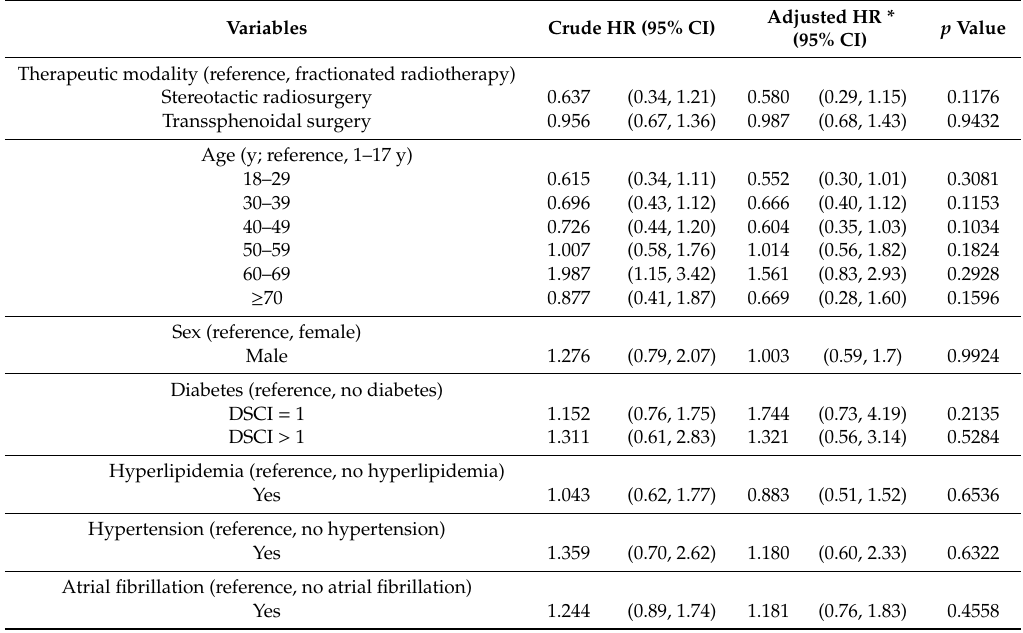
Table 4. Cox proportional hazards regression analysis of optic nerve injury risk in patients with nonfunctioning pituitary macroadenomas who received di ff erent